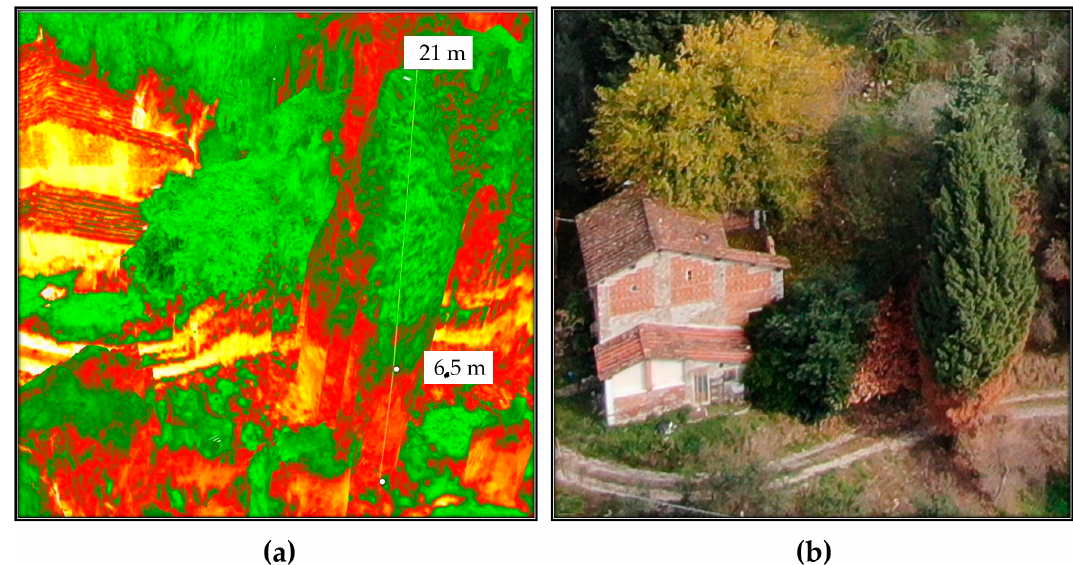
Figure 18. ( a ) NDVI flame height evidence; ( b ) optical flame